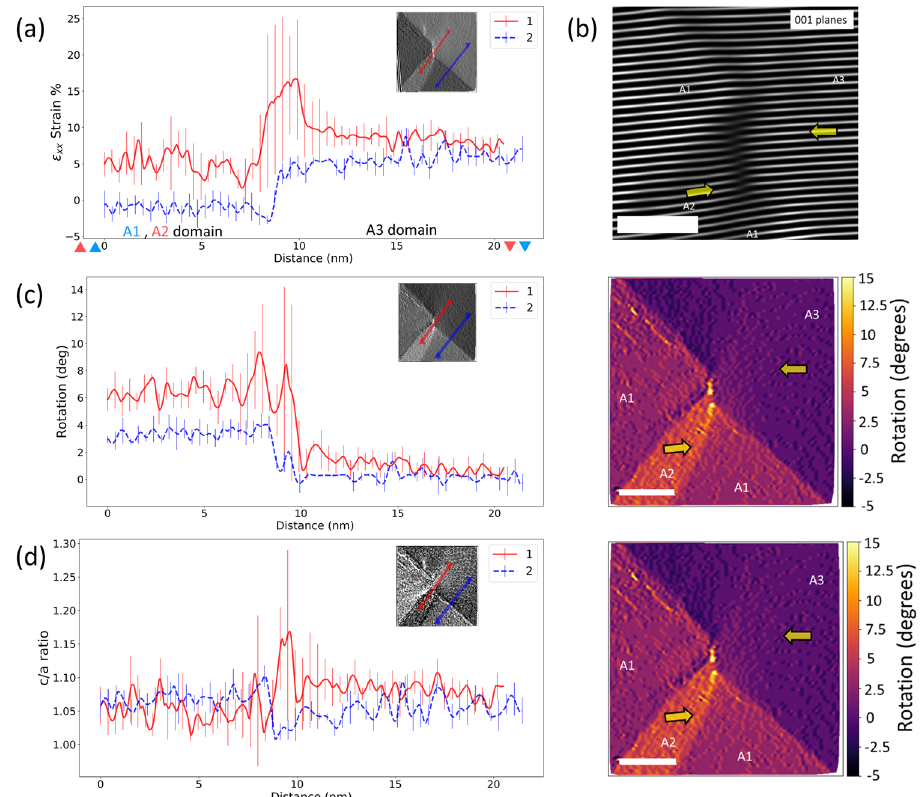
Fig. 2 Structural differences between the charged needle point and a neutral twin domain wall boundary. Comparison of structural parameters across the charged needle point (red, solid line) and the neutral twin boundary (blue, dotted line). Inset are maps of the parameter indicating where the pro fi les displayed in the graphs are extracted from. a ɛ xx strain pro fi les. b Fourier fi ltered image showing the (001) planes at the charged needle point. Scale bar = 4 nm. Despite the massive strain there is no dislocation present. c Pro fi les and map of the relative structural rotation. Scale bar = 8 nm. d Pro fi les and map of the tetragonality of each unit cell measured by c/a ratio. Scale bar = 8 nm. Error bars are + / − the standard deviation of the 100 pixel values (~4 unit cells) over which the pro fi le is averaged. They are placed at approximately each unit cell along the pro fi